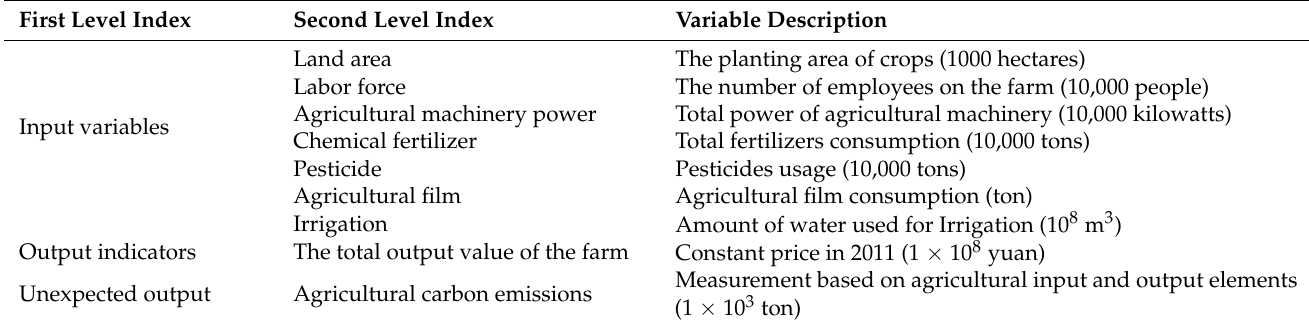
Table 1. Input and output variables for measuring ACEP.